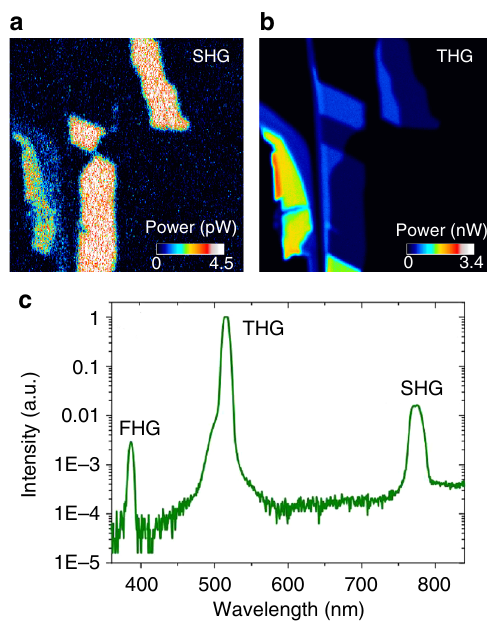
Fig. 3 Multiphoton images of MoS 2 fl akes. a SHG and b THG map of the fl akes in Fig. 1a. c Optical spectrum of the nonlinear signal from 1L-MoS with a peak irradiance ~30 GW cm −